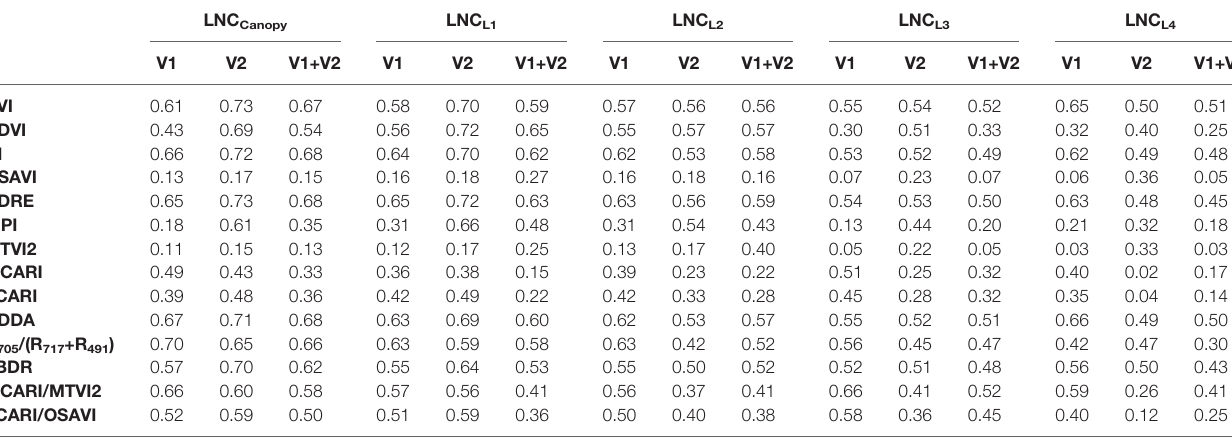
TABLE 2 | Coef fi cients of determination (R 2 ) for the relationship between the vegetation indices and the leaf nitrogen concentration in different rice cultivars. LNC Canopy